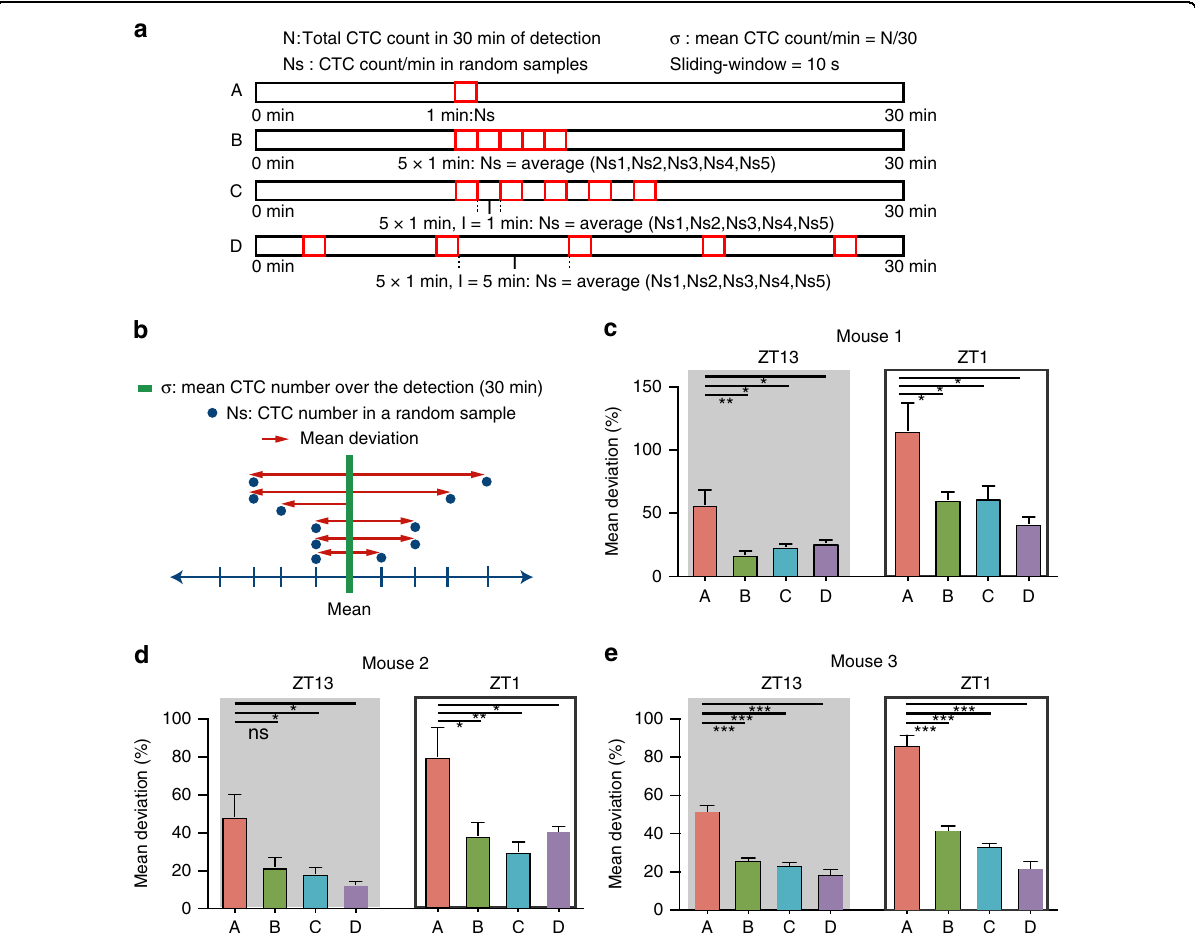
Fig. 4 Multiple sampling improves detection accuracy. a Schematic of different sampling strategies. b Diagram of computing the mean deviation. c – e Mean deviation of different sampling strategies, unpaired t -test. * P < 0.05, ** P < 0.01, *** P < 0.001. All data are presented as the mean